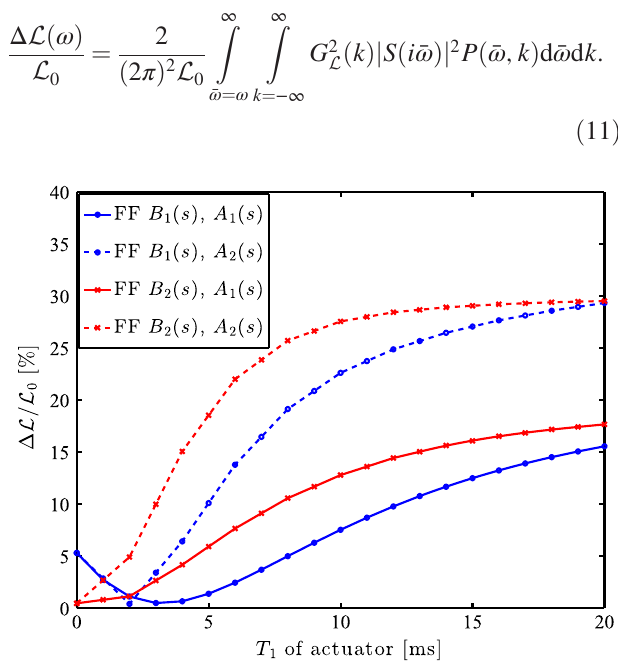
FIG. 2. Relative luminosity loss with the feed-forward and orbit feedback system with respect to the actuator dynamics for the case of CLIC.